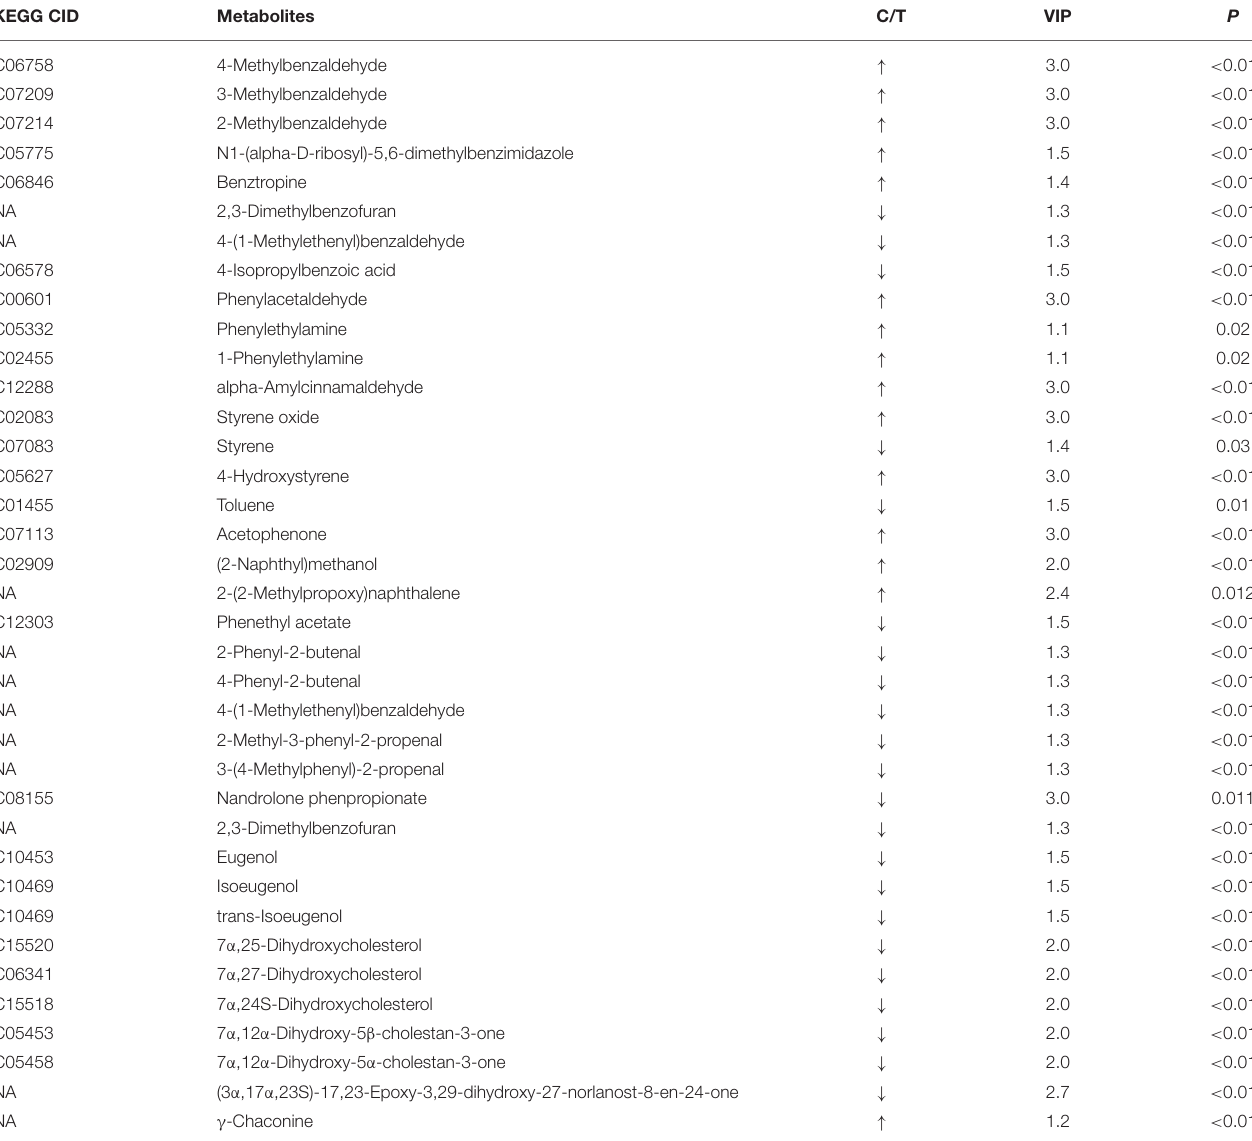
TABLE 3 | Differential xenobiotic and other secondary metabolite biomarkers with higher levels in controls than antibiotic-fed pupae in positive ion mode. KEGG